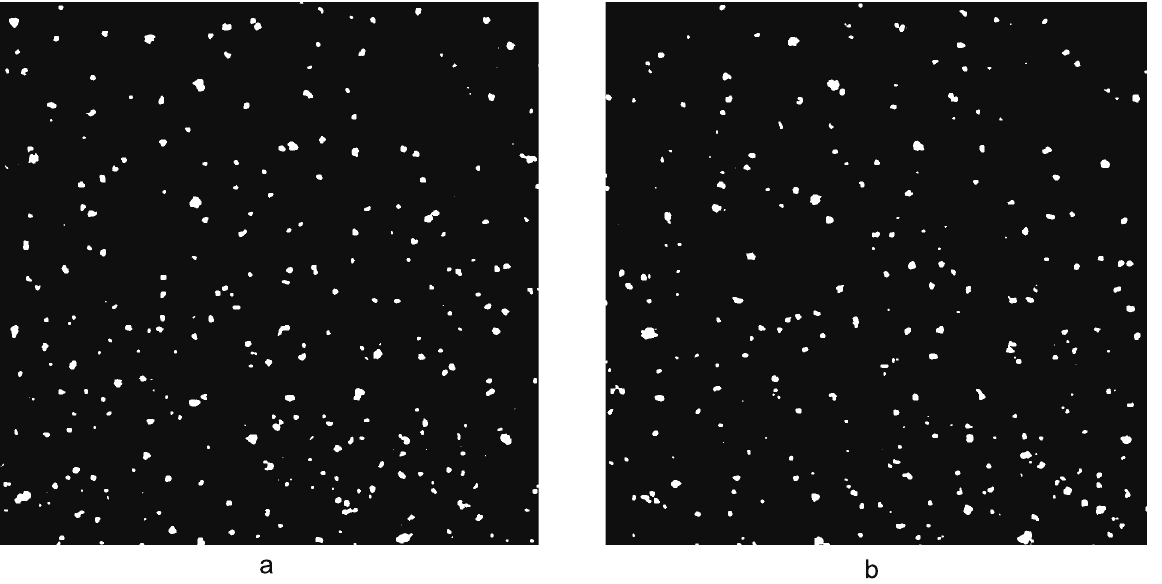
Figure 3. Part of an example image pair. (a) shows the former image in a pair and (b) reveals the latter one. In the image, the white spots represent the particles flying in the air.